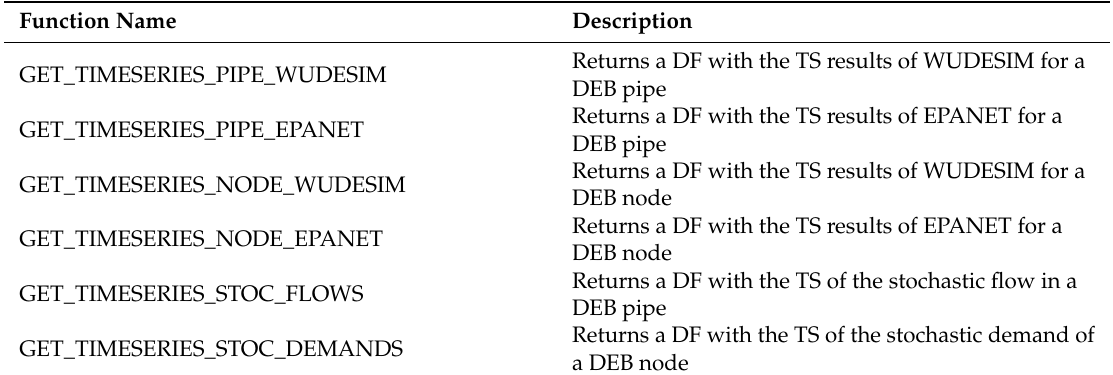
Table 8. Description of Get Time Series Functions.